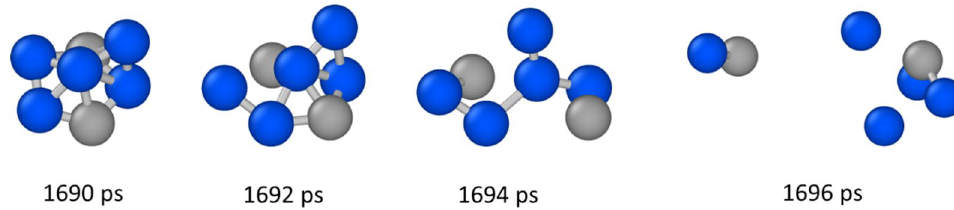
Figure 6. Dissociation of a cluster in Al–0.5Ni. Al atoms in gray. Ni atoms in blue.